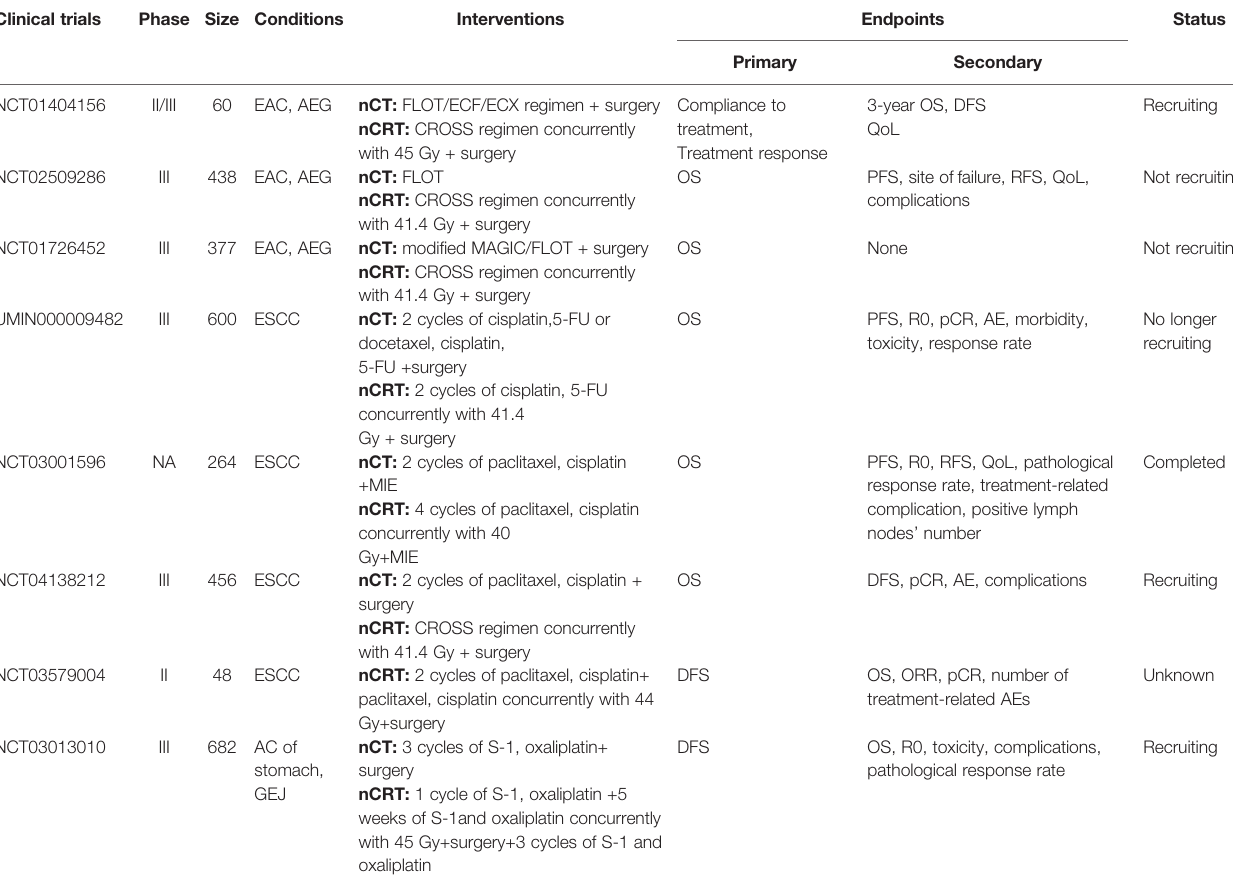
TABLE 5 | Characteristics clinical trials regarding neoadjuvant chemotherapy vs. neoadjuvant chemoradiotherapy. Clinical